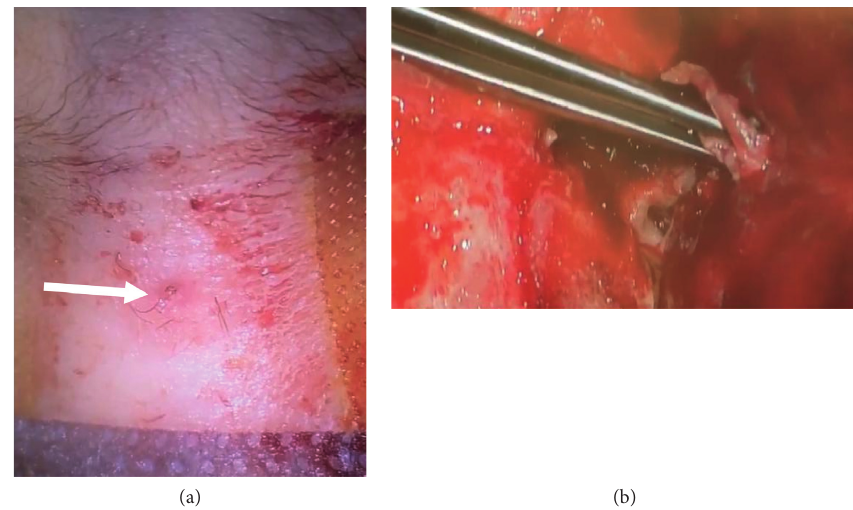
Figure 2: Gross appearance of the lesion. (a) The cutaneous lesion with a few hair strands on the nasal bridge (white arrow). (b) Intraoperative image showing the sinus tract that was leading to the forehead, being held by the surgical